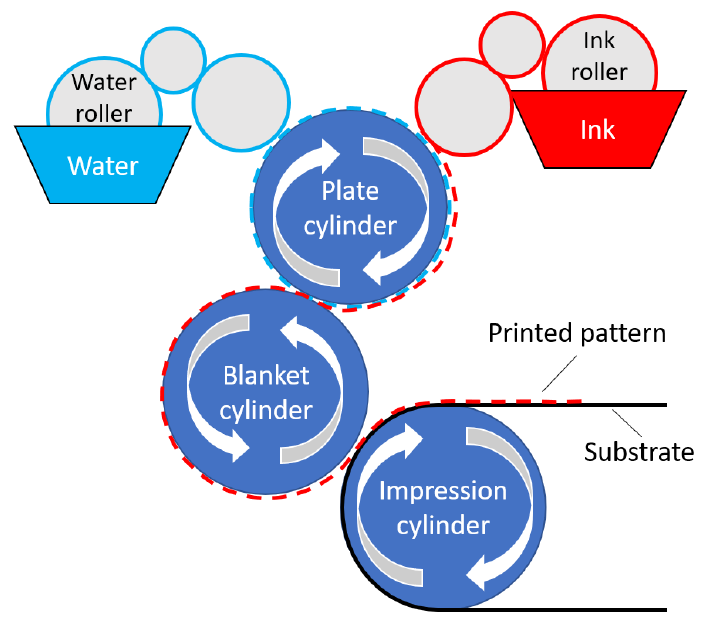
Figure 13. Schematics of offset printing.